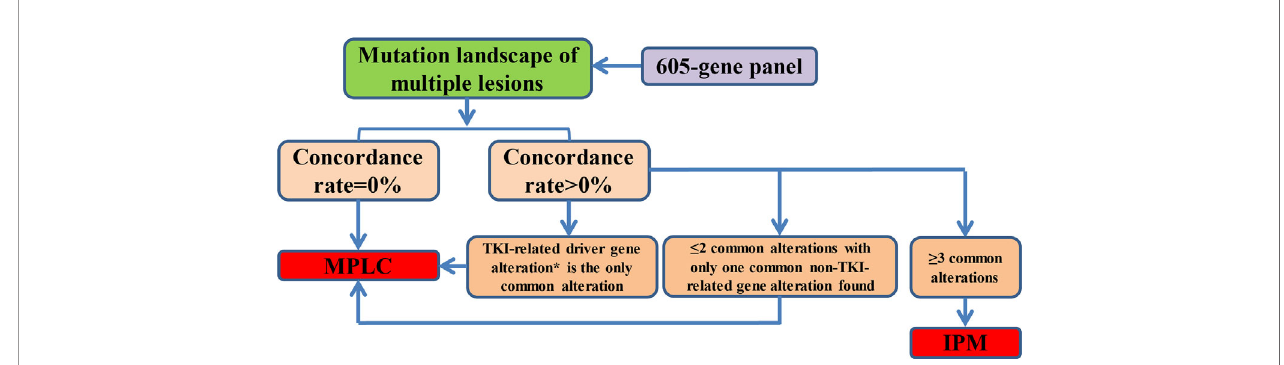
FIGURE 3 | Flowchart shows the interpretation procedure and criteria for distinguishing MPLC from IPM. *TKI-related driver gene alterations include EGFR (SNV, INDEL, Amp), ALK (fusion), ROS1 (fusion), MET (fusion, skipping, Amp), RET (fusion, Amp), BRAF (SNV, INDEL), and KRAS (SNV, INDEL).